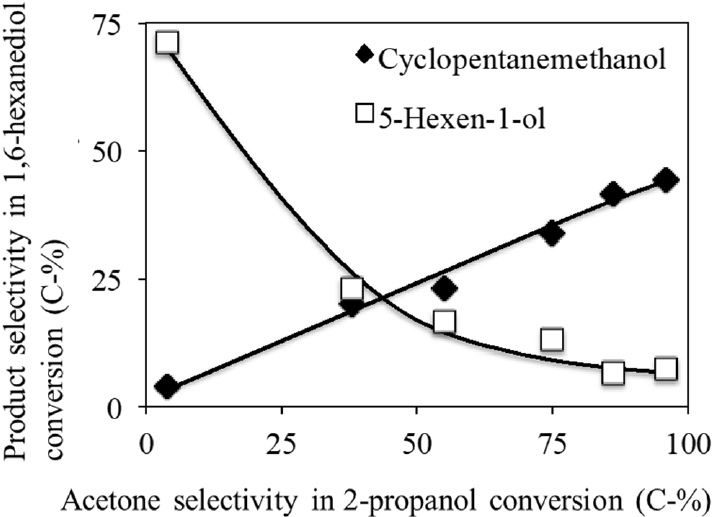
Figure 4. Effects of acid–base property on the products selectivity in the 1,6-hexanediol conversion over the Ca-HAP catalysts with various Ca/P molar ratios.